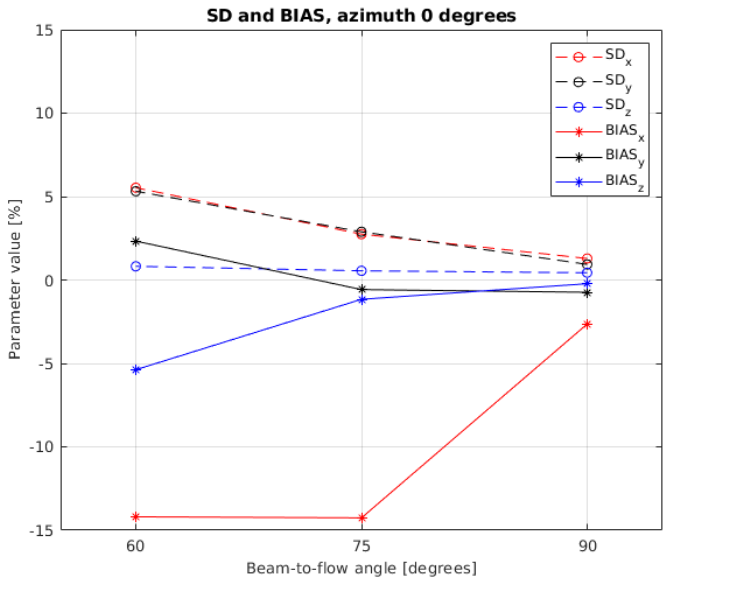
Figure 5. RSD and RB for simulations with (90, 75, 60) degrees beam-to-flow anlges and 0 degrees rotation angle. The dashed lines show the relative standard deviation, the solid lines show the relative bias. The red color is v x , the black is v y and the blue is v z components of the flow. Figure 6 shows the profiles along the center lines for a 45 degree azimuthal rotation and the three beam-to-flow